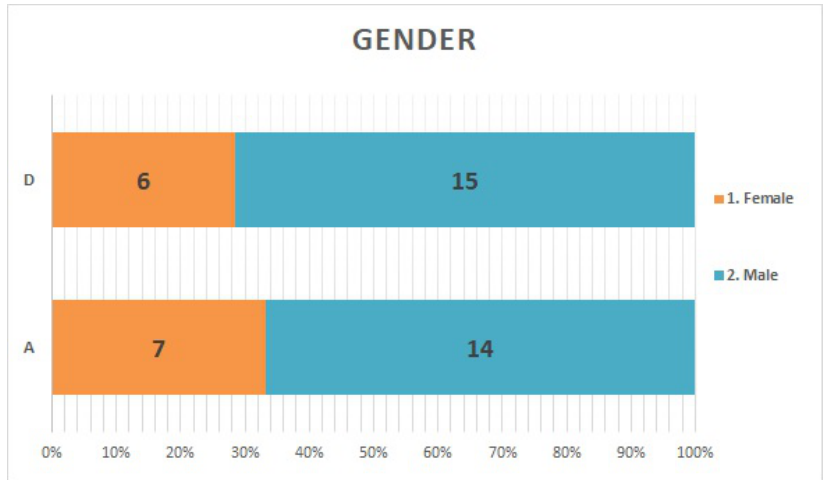
Figure 1. Gender: Both facilities had more than twice as many men as women.